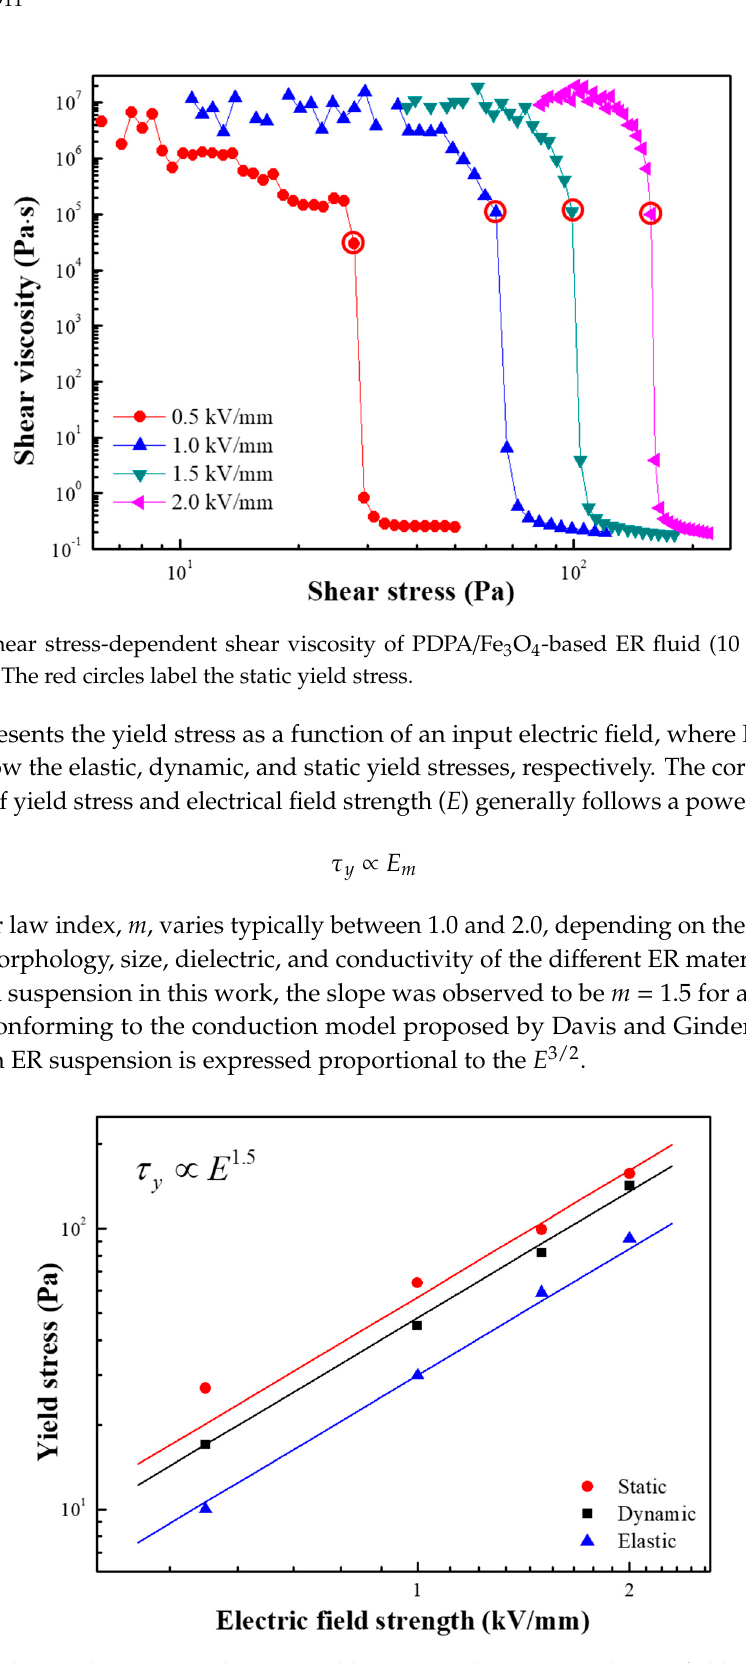
Figure 9. Elastic, dynamic, and static yield stress under various electric field strengths for PDPA / Fe 3 O 4 -based ER fluid (10 vol%, 50 cSt silicone